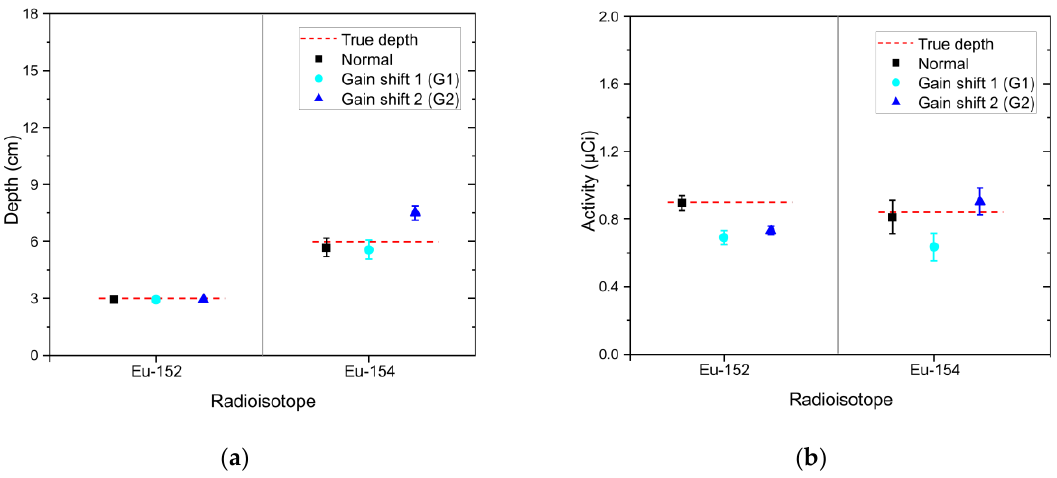
Figure 13. ( a ) Estimated depth and ( b ) activity of identified radioisotopes (i.e., Eu-152 and Eu-154) in the form of mean and 1.96 standard error analyzed for a 30-s measured spectrum composed of Eu-152 and Eu-154 buried in sand at depths of 3 cm and 6 cm (black square) and its shifted spectra (sky-blue circle and blue triangle). The red dotted lines denote the true values.